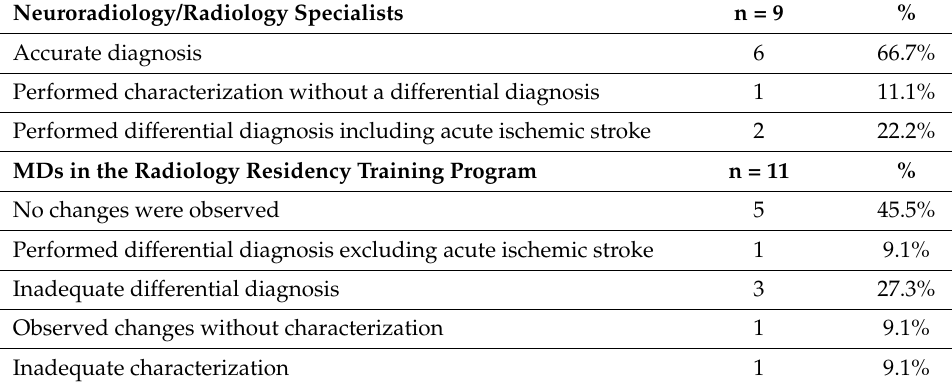
Table 1. Analysis of the answers to the first question: Analyzing Figure 13a (non-contrast MDCT image of the patient’s endocranium), what is your opinion on whether there are changes in the brain, and if there are, what changes are